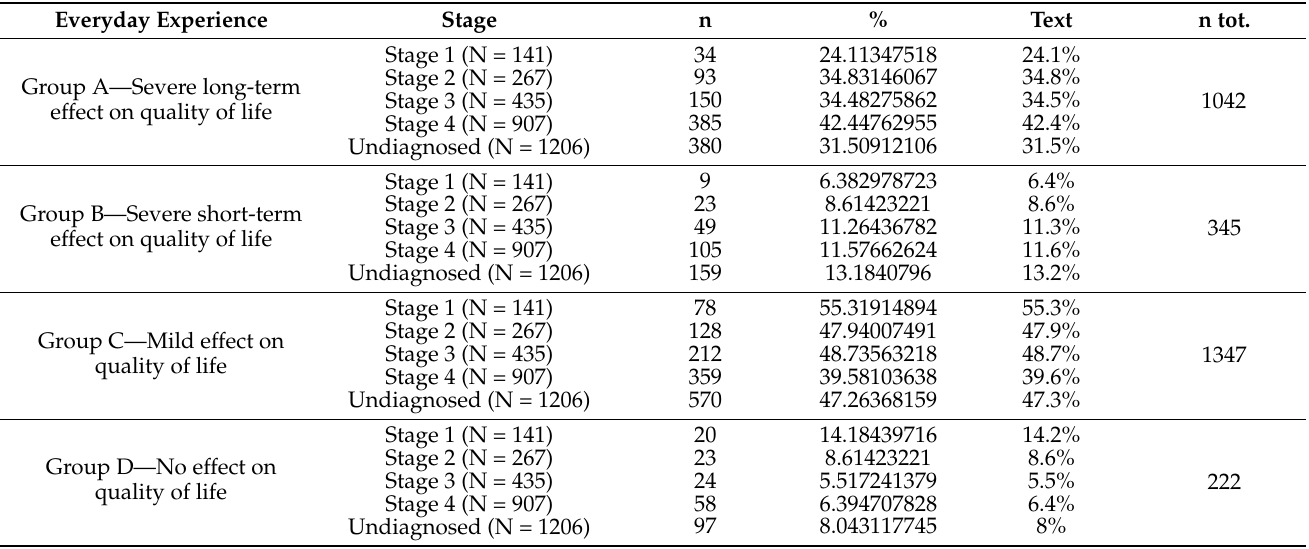
Table 2. Everyday experiences of quality of life by participants in relation to stage at time of completing the questionnaire.